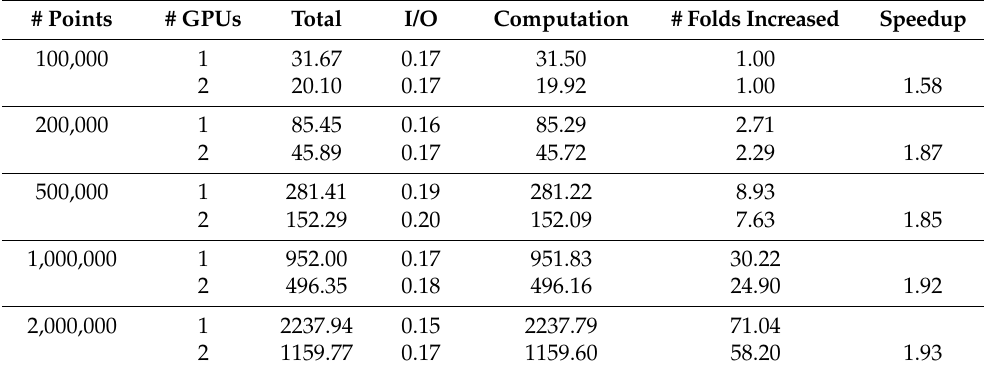
Table 2. Execution time (in seconds) for density estimation with adaptive bandwidths on synthetic datasets (varied number of points; density raster cell size =